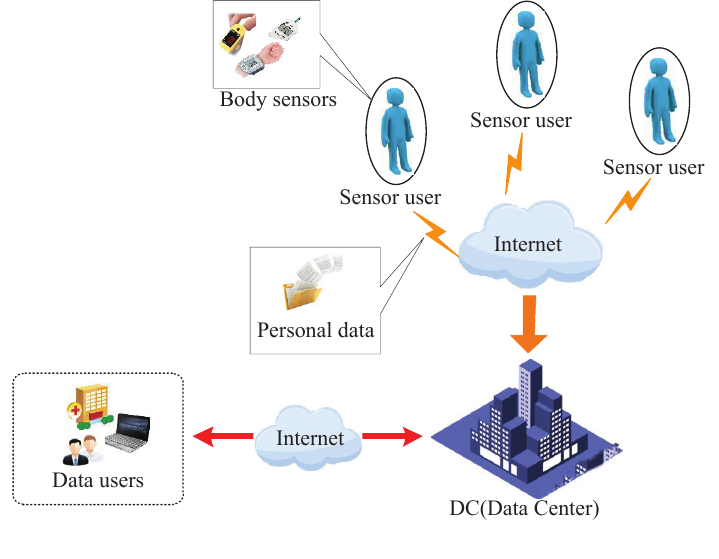
Figure 1. Body sensor data collection and query service